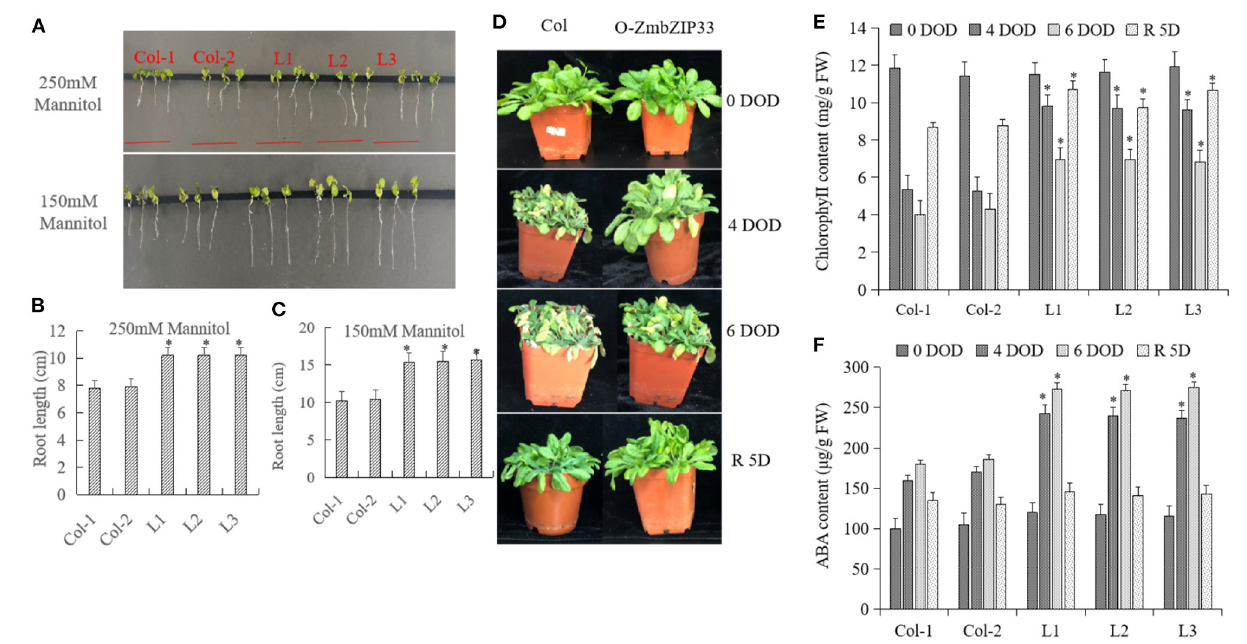
FIGURE 5 | The root length and the contents of chlorophyll and ABA in overexpression ZmbZIP33 transgenic Arabidopsis . (A) Col is the wild type (WT), L1–L3 are ZmbZIP33 transgenic lines. Five-days old seedlings were transferred and grown for 3 days on MS medium supplemented with 250 and 150mM of Mannitol. (B/C) The root lengths of ZmbZIP33 transgenic Arabidopsis and Col-0 in 250 and 150mM of Mannitol. (D) Col and O-ZmbZIP33 plants were exposed for 4 and 6 days of drought (DOD). The plants were then rewatered for 5 days (R 5D) and photographed. (E/F) The contents of chlorophyll and ABA of Col and L1–L3 leaves were measured under drought stress and rewatering. Mean values and standard errors (bar) were shown from five independent experiments. Independent t -tests for equality of means demonstrated that there was significant difference between control and treatment (* P value <